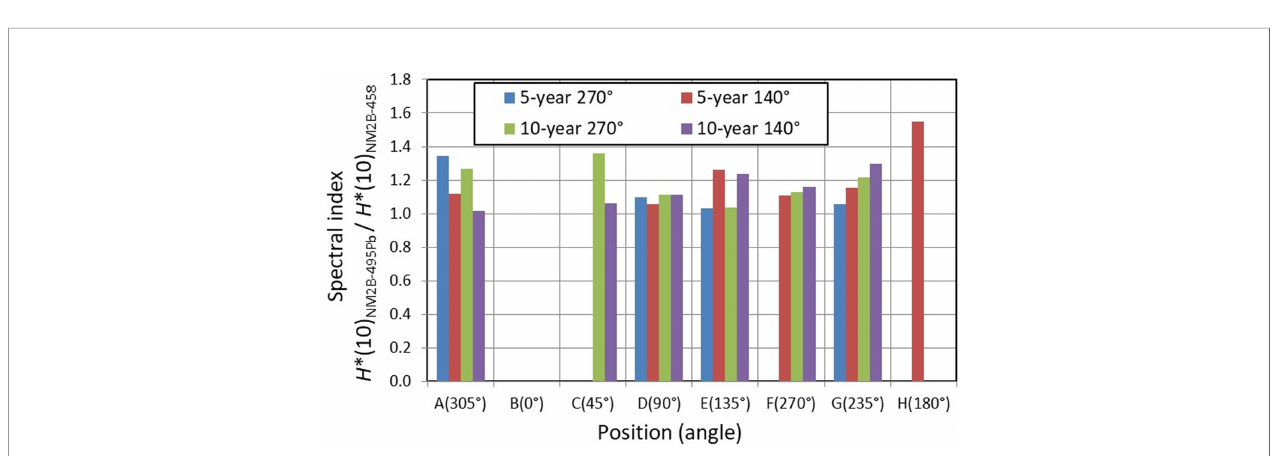
FIGURE 6 | Neutron spectral index expressed as a ratio of H *(10) values measured with NM2B-495Pb and NM2B-458 rem counters at different positions (and different angles with respect to the beam direction) around 5- and 10-year-old pediatric phantoms.